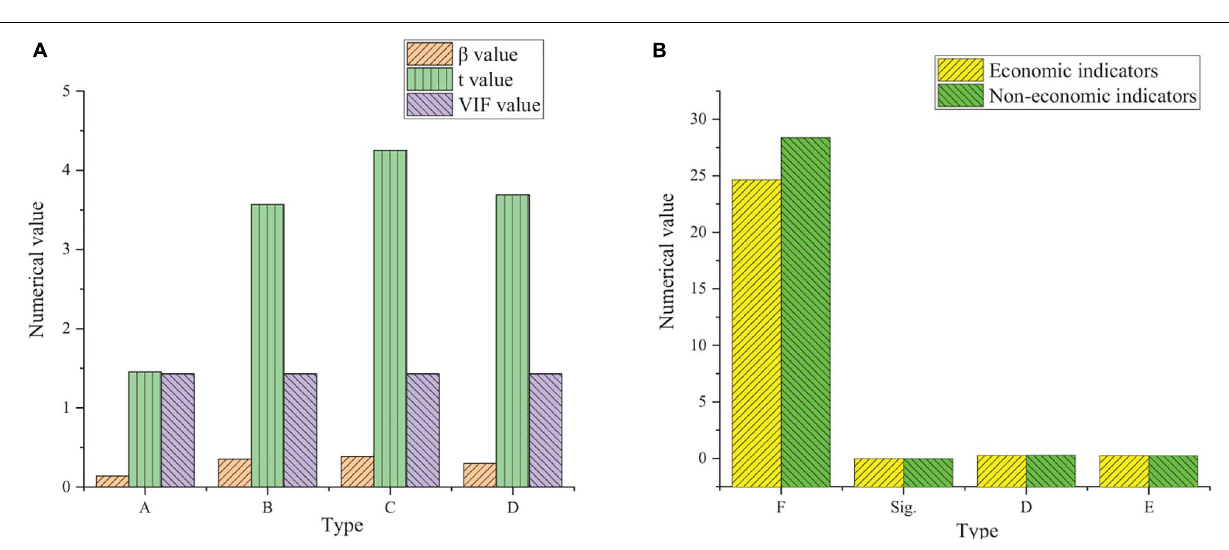
FIGURE 6 | Regression Analysis of entrepreneurial passion and entrepreneurial performance at all levels [ (A) data analysis data; (B) calculation and statistics; A, Entrepreneurial passion; B, Risk taking Work; C, engagement; D, R 2 ; E, (cid:77) R 2 ].